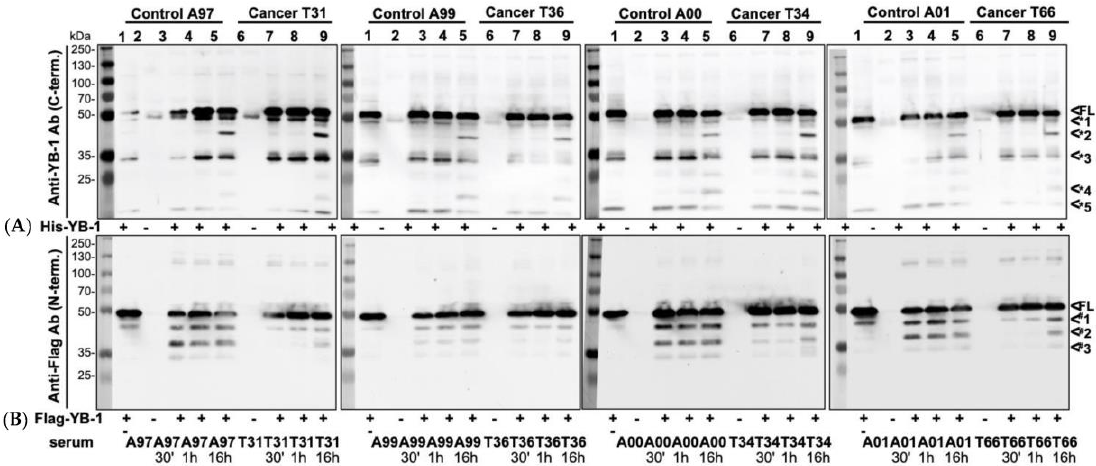
Figure 7. E ff ect of serum autoantibodies directed against cold shock protein YB-1 on protein degradation. ( A ) Prokaryotic His-YB-1 was incubated for 30 min, 1 h, and 16 h with a serum of healthy volunteers (lane 3–5) and cancer patients (lane 7–9) at 37 ◦ C. His-YB-1, healthy and cancer serum alone were also applied (lane 1, 2, 6). His-YB-1 decays in 3 fragments of about 48 kDa, 32 kDa, and 15 kDa (*1, *3, *5) molecular weight. Serum probes show no fragmentation. Healthy and cancer incubated His-YB-1 show a stronger signal than His-YB-1 alone. After 16 h of incubation 2 additional fragments of approximately 40 kDa (*2) and 20 kDa (*4) molecular size were detected. ( B ) Eukaryotic Flag-YB-1 was incubated for 30 min, 1 h, and 16 h with a serum of healthy volunteers (lane 3–5) and cancer patients (lane 7–9) at 37 ◦ C. Flag-YB-1, healthy and cancer serum alone were also applied (lane 1, 2, 6). Flag-YB-1 alone decays in one further fragment of about 45 kDa (#1). The control group presents already after 30 min of incubation 2 further fragments of about 35 kDa and 30 kDa (#2, #3) molecular size. The Cancer group only shows one additional fragment at approximately 35 kDa.